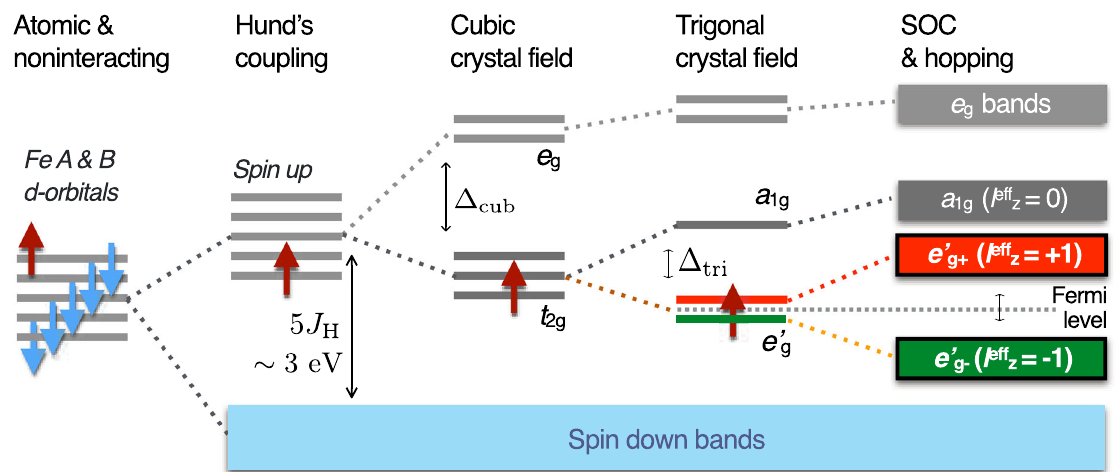
Fig. 1 Energy level diagram of Fe 2+ in BaFe 2 (PO 4 ) 2 (BFPO), with respect to inclusion of relevant energy scales U > J H > Δ cub > Δ tri ≳ λ SO ≈ t